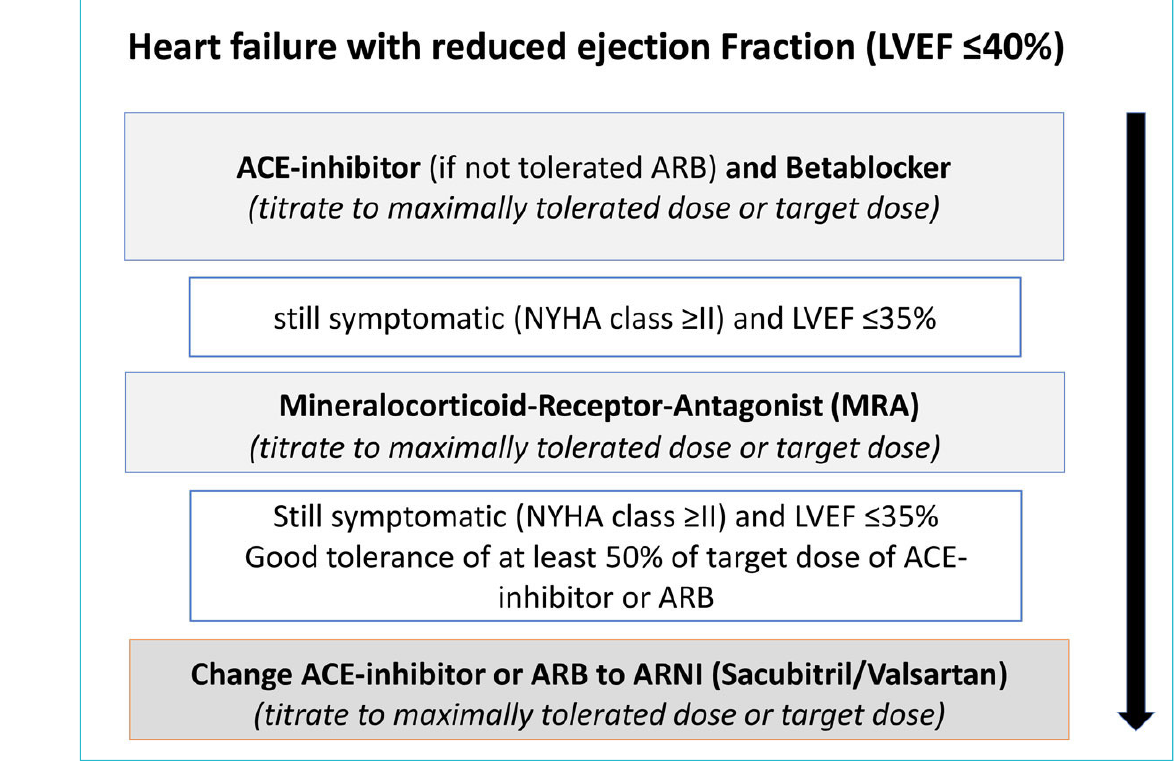
Figure 2: Guidance on the introduction of an ARNI in clinical practice. Criteria for the commencement of treatment with a combined an- giotensin II receptor/neprilysin inhibitor (ARNI) based on the 2016 ESC guidelines for the diagnosis and treatment of acute and chronic heart failure [1] are depicted. LVEF: left-ventricular ejection fraction; ACE: angiotensin converting enzyme; ARB: angiotensin receptor